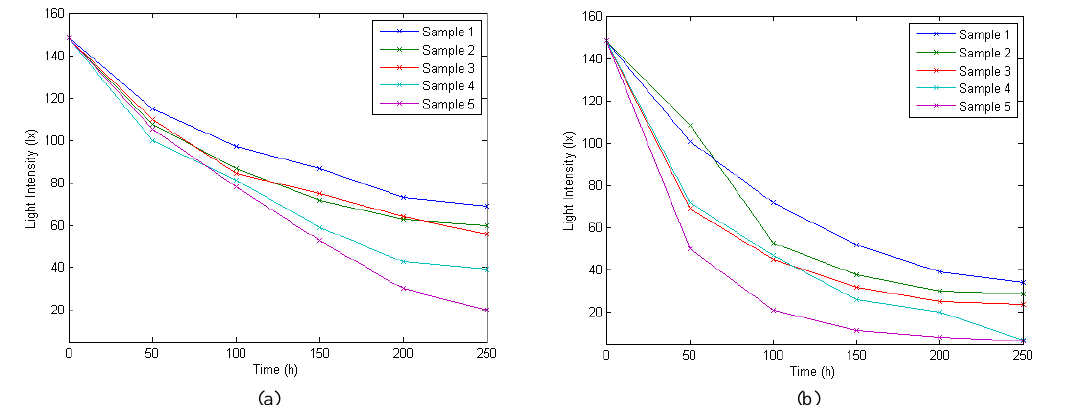
Figure 1. LEDs degradation path at stress level a)140 0 C and 35 mA b)165 0 C and 40